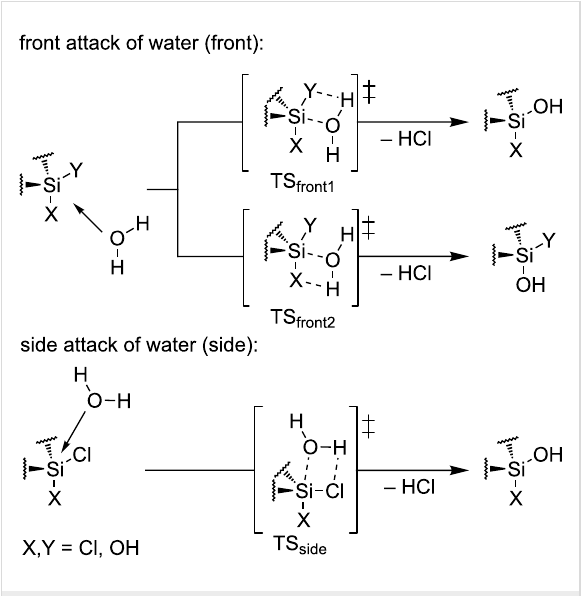
Scheme 5: Two investigated pathways for the hydrolysis of the dichlorosilanes. Front attack mechanism (front) between the two chloro substituents or side attack mechanism (side) between one chloro and both additional substituents (TS = transition structure) [62-68].